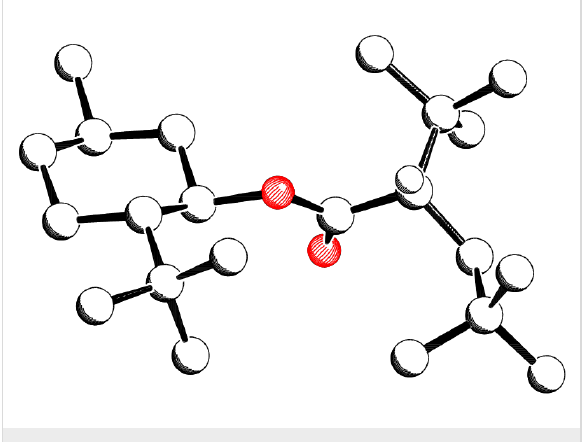
Figure 2: Crystal structure of the minor diastereomer 23b .